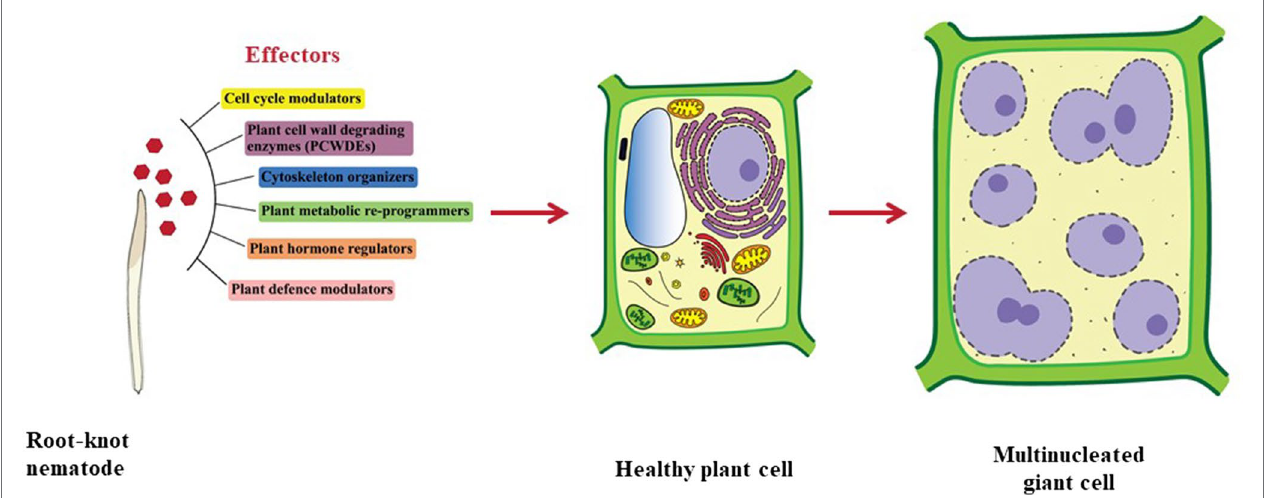
FIGURE 2 | Types of effectors secreted by RKNs. Effectors secreted by RKNs are divided into various categories namely cell cycle modulators, PCWDEs, cytoskeleton organizers, plant metabolic re-programmers, plant hormone regulators, and plant defence modulators. Various effectors from these categories work in tight coordination to modify normal plant cells into